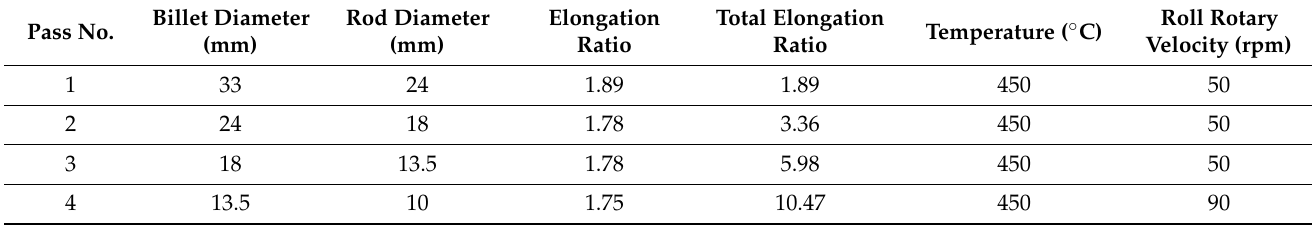
Table 2. Modes of radial shear